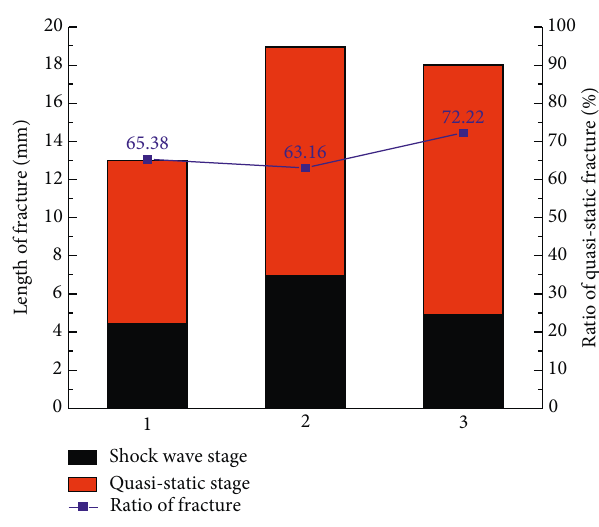
Figure 3: Fracture length at different stages. Table 1: Design of experimental